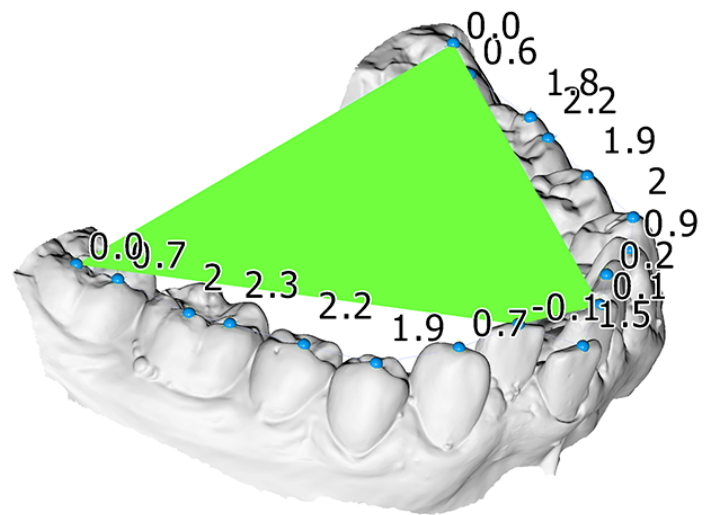
Figure 1. Mandibular dental model of a patient included in this study. A best fit occlusal plane (green), constructed through landmarks placed on each tooth (blue spheres), was used to measure the curve of Spee. The numbers indicate the vertical distance of each tooth cusp landmark from this plane, used to calculate the average and the maximum curve of Spee measurement.